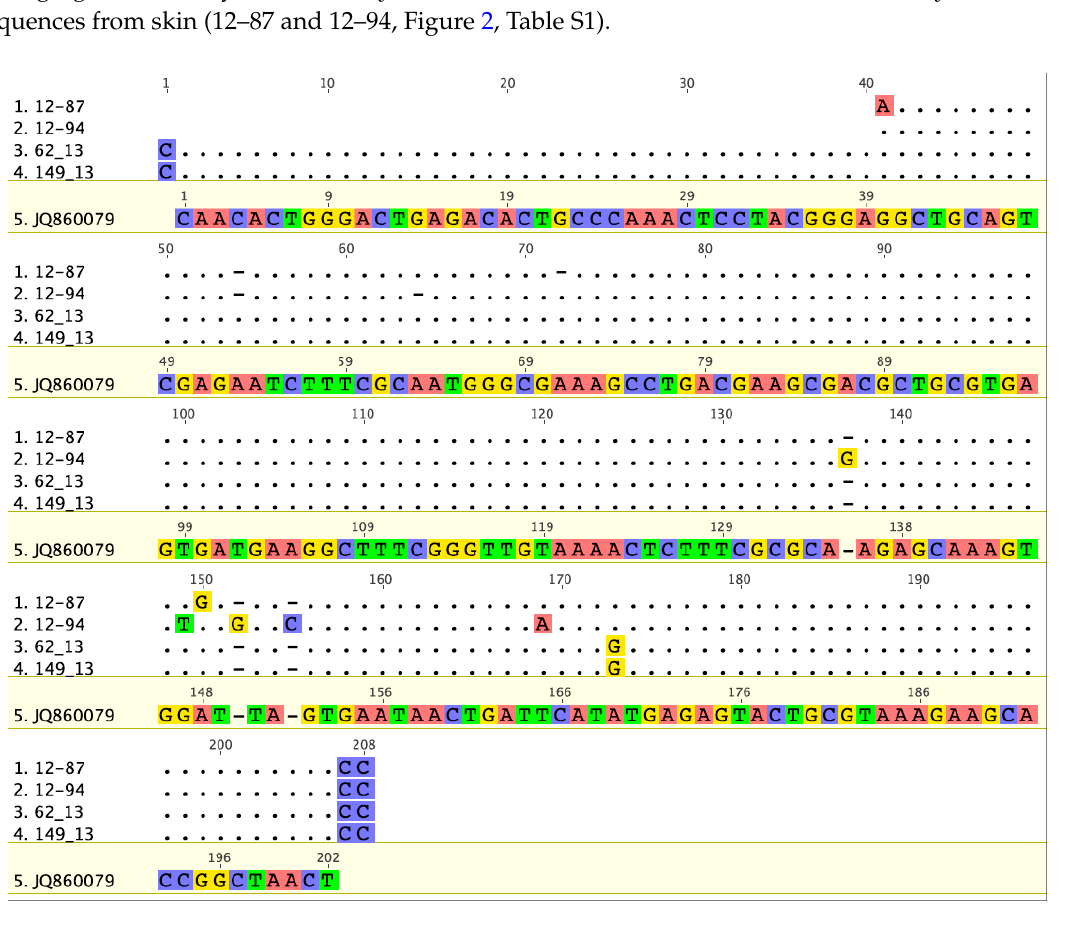
Figure 2. Comparative analysis of the CLO 16S rRNA sequences from ticks (63_13 and 149_13) and two skin biopsies (12–87 and 12–94). The sequences are 95%–98% similar. The best BLAST match for tick CLO sequences (JQ86007, from Ixodes ricinus ) is shown as a reference. Geneious version 6.1 created by Biomatters. Available from http://www.geneious.com .